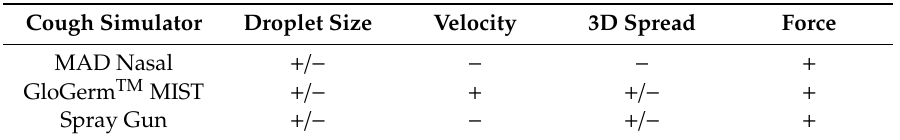
Table 1. Cough simulator comparison. Each cough simulator is given a + or − for each parameter, indicating that the simulator either meets the physiological criteria or does not. A +/ − is given if the cough simulator meets some but not all of the criteria. Cough Simulator Droplet Size Velocity 3D Spread Force MAD Nasal +/ − − − + GloGerm TM MIST +/ − + +/ − + Spray Gun +/ − − +/ −